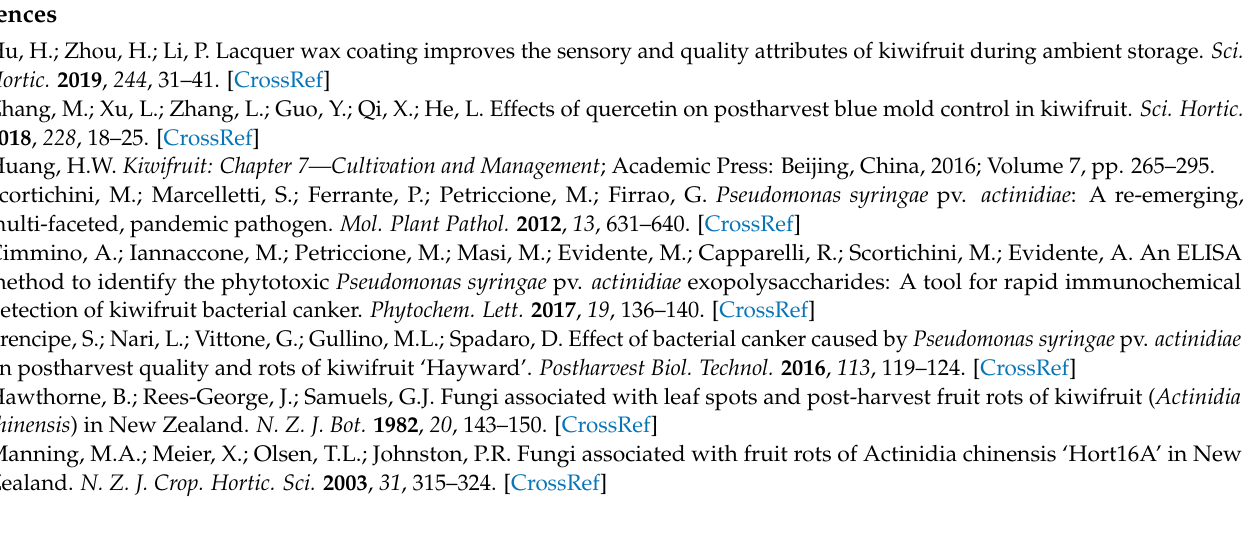
Figure S2. The plot distribution figure of field experiment of soft rot, blossom blight and brown spot diseases in